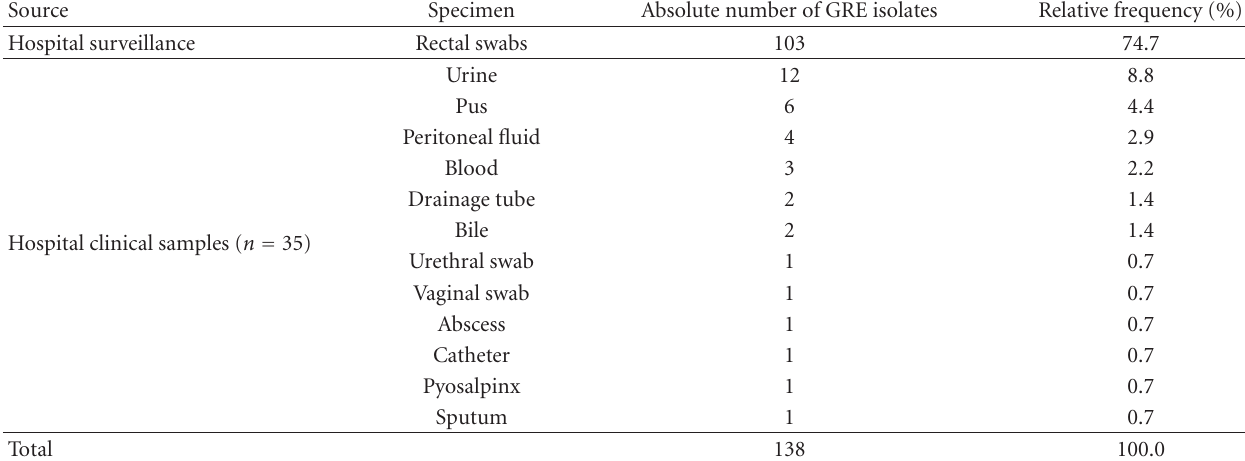
Table 1: Frequency of glycopeptide-resistant enterococci (GRE) in relation to the number of clinical samples.